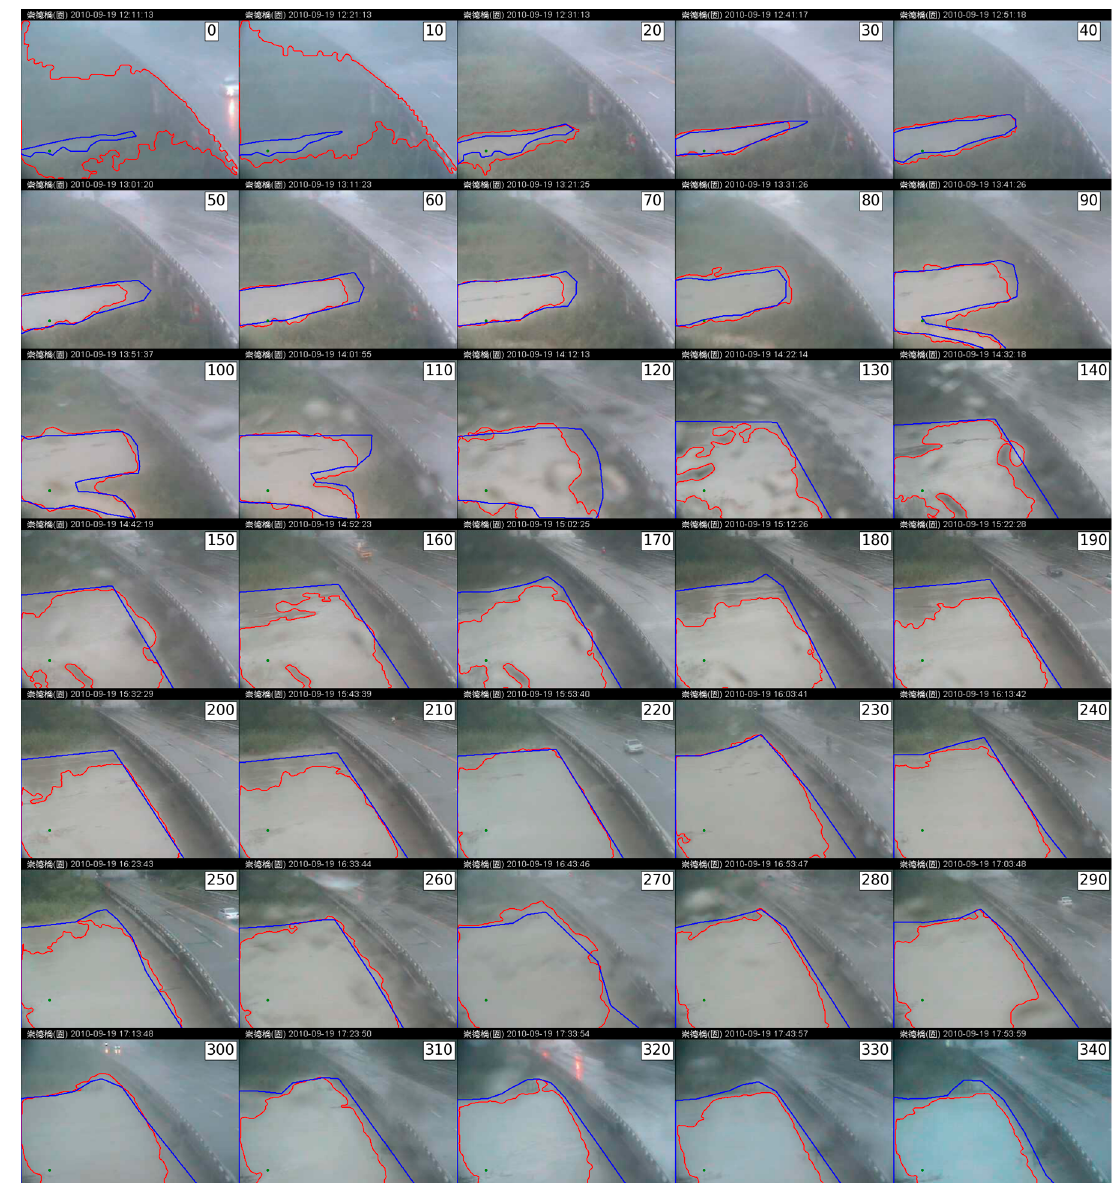
Figure 10. Part of RegGro’s results with red segments from growing methods. The blue line is the ground truth, and the green marker is the initial seed for the growing methods. There were few flood segmentation failures in heavy rain and fog. Some failures occurred with raindrop stains on the CCTV screen. (Note: The Traditional Chinese in header of all images is represented the location in the Changed Bridge except).